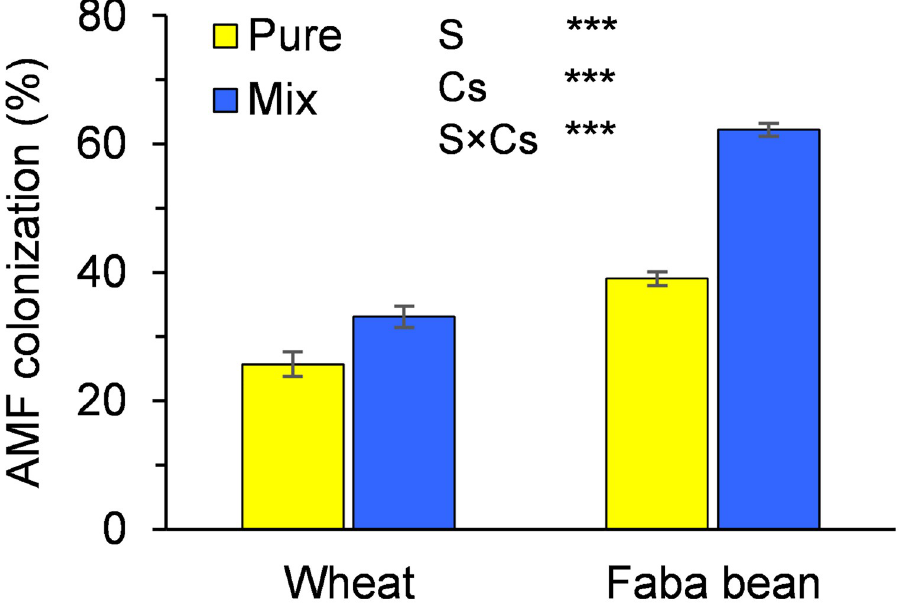
Fig 1. Root colonisation (%) by arbuscular mycorrhizal fungi in wheat and faba bean grown in pure stand (Pure) and in mixture (Mix). S, species; Cs, cropping system. ��� indicates significant differences at P � 0.001. Vertical bars indicate standard errors of each mean value (n =